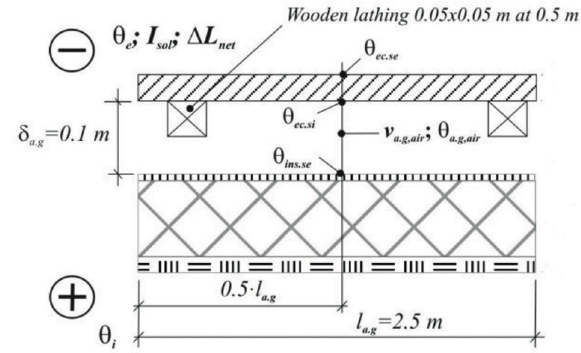
Fig. 3. Principal scheme of experimental cell roof construction